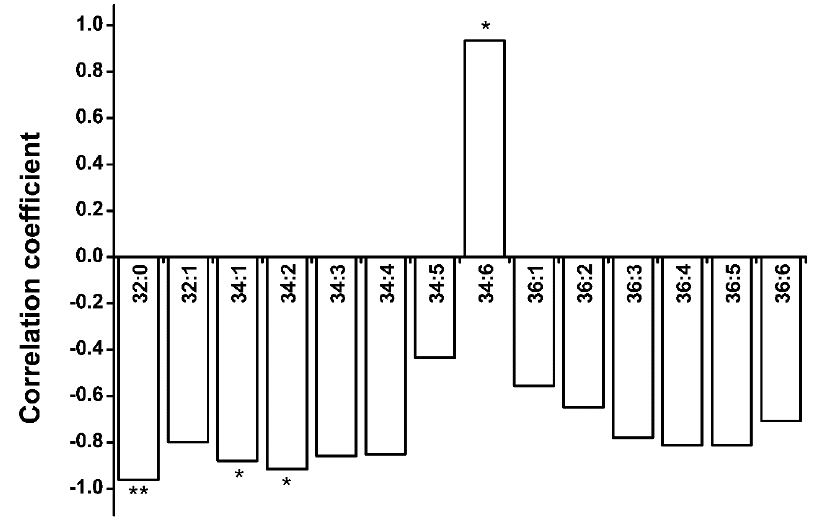
Figure 8. Correlation coefficients for group A and B of 14 molecular species. In group A, PA and DAG harbor all 14 molecular species. In group B, PG, PC, PE, and PI harbor 32:0 molecular species; PG, PE, and PI harbor 32:1 molecular species; DGDG, MGDG, PG, PC, PE, PI, and PS harbor 34:1, 34:2, 34:3, molecular species. The bars with asterisks are significantly different (* p < 0.05, ** p <